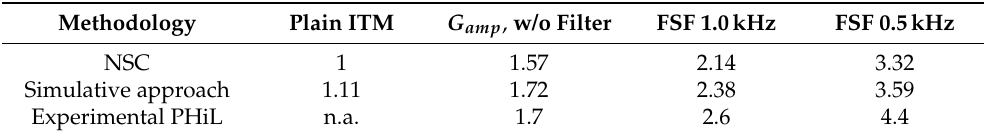
Table A1. Comparison of critical impedance ratio with theoretical stability criterion, simulative approach with offline- emt -model and practical PHiL simulation with the switching inverter.